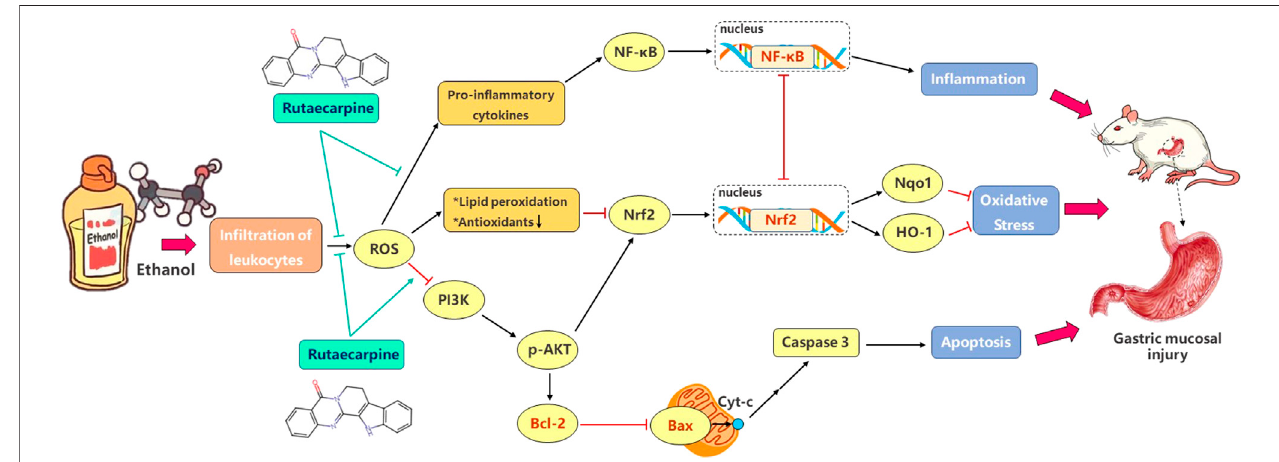
FIGURE7| Schematicdiagramofsignalpathwaythatmediatesethanol-inducedgastricmucosalinjuryandtheameliorativeeffectsofRUTonmice.( → :activate; ˧ : inhibit).